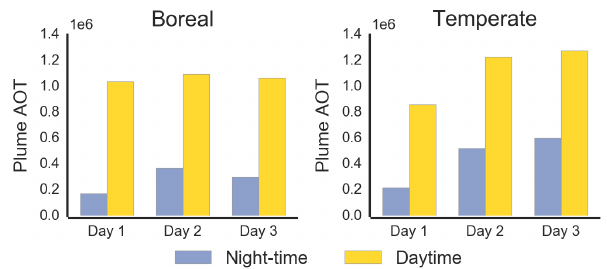
Figure 2. Changes in attributed AOT over time. Image shows 39 boreal and 37 temperate diurnal emission cycles for which estimates were obtained on 3 consecutive days, for both daytime and night- time